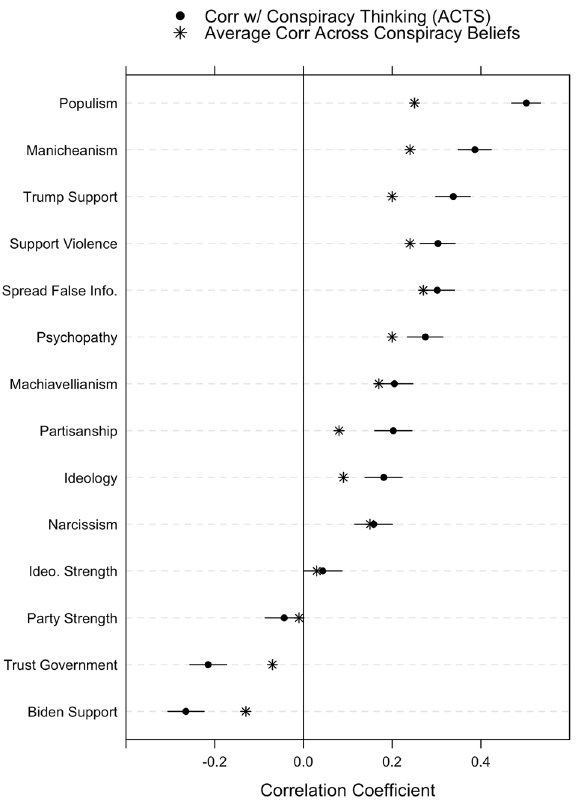
Figure 5. Pearson correlations between conspiracy thinking (ACTS) and each psychological and political correlated, with 95% confidence intervals. Also depicts average correlation for each correlate across all 39 conspiracy theory